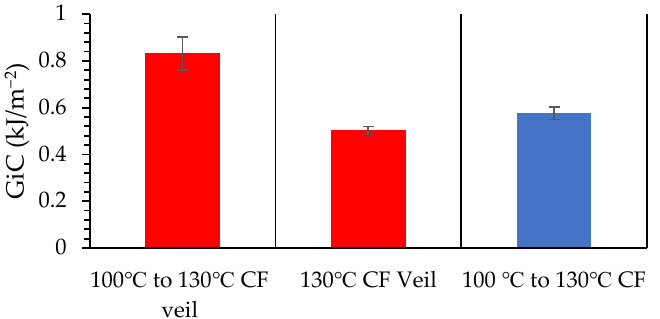
Figure 3. Interlaminar fracture toughness Mode I testing for carbon fibre composites isothermally cured at 100 °C and 130 °C, veil toughened carbon fibre isothermally cured at 130 °C, veil toughened carbon fibre isothermally cured 100 °C and 130 °C.